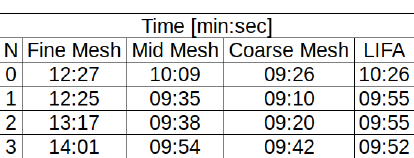
Table 7: Multiphysics Runtimes Table 8: Multiphysics Memory